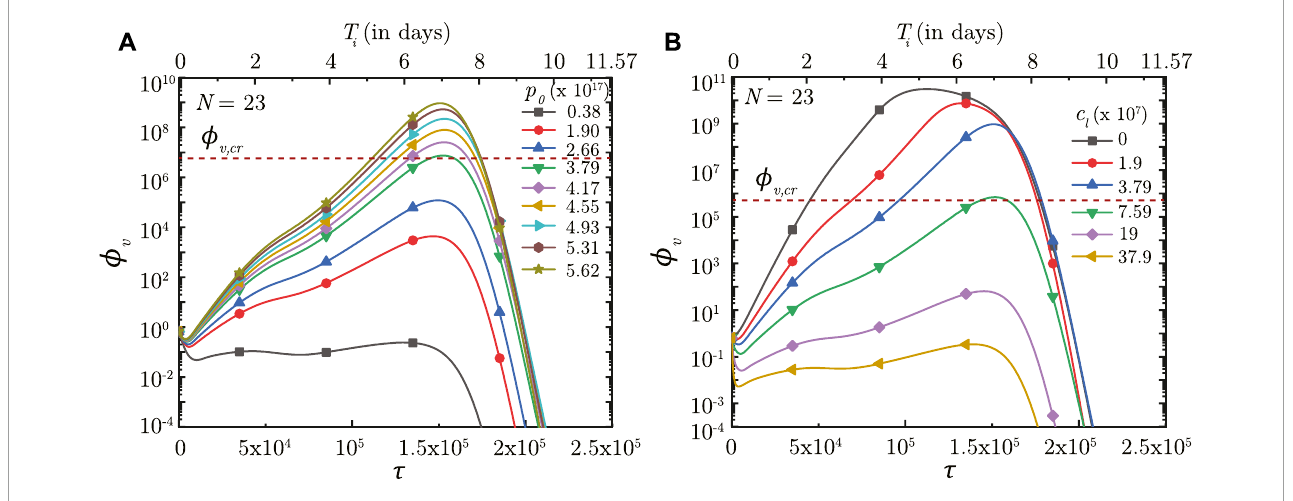
FIGURE 7 Temporal change in dimensionless virus concentration ( ϕ v ) at N = 23 (deep lung) for different (A) virus replication rates ( p 0 ) and (B) virus clearance rates ( c L ) . The results are shown with respect to dimensionless time ( τ ) as well as a dimensional time ( T i ) post infection onset with the breathing time period ( T b = 4s) considered for obtaining the dimensional time (see Eq. 7 ). The dotted line indicates the critical viral load ( ϕ v , cr ) in the deep lung required for pneumonia onset (Fajnzylber et al.,